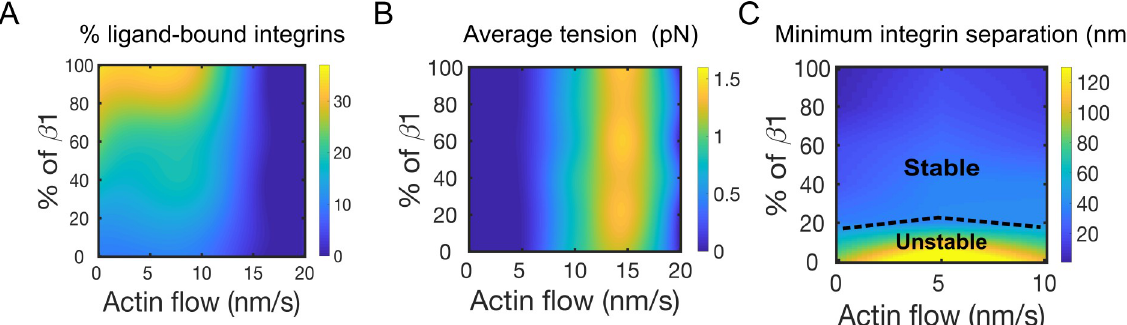
Fig 5. Amounts of β -1 and β -3 integrins determine ligand binding, traction stress, and adhesion stability. (A) Percentage of ligand-bound integrins by varying fraction of β -1 in a system of β -3 integrins, as a function of actin flow speed. (B) Average tension per integrin varying actin flow speed and percentage of simulated β -1 in a system of β -3 integrins. (C) Average distance between nearest ligand-bound integrins, without distinction between β -1 and β -3 integrins. Represented are regions of unstable and stable adhesions, depending upon the minimum spatial separation between any integrin type. Data are computed as averages between 1–120 s of